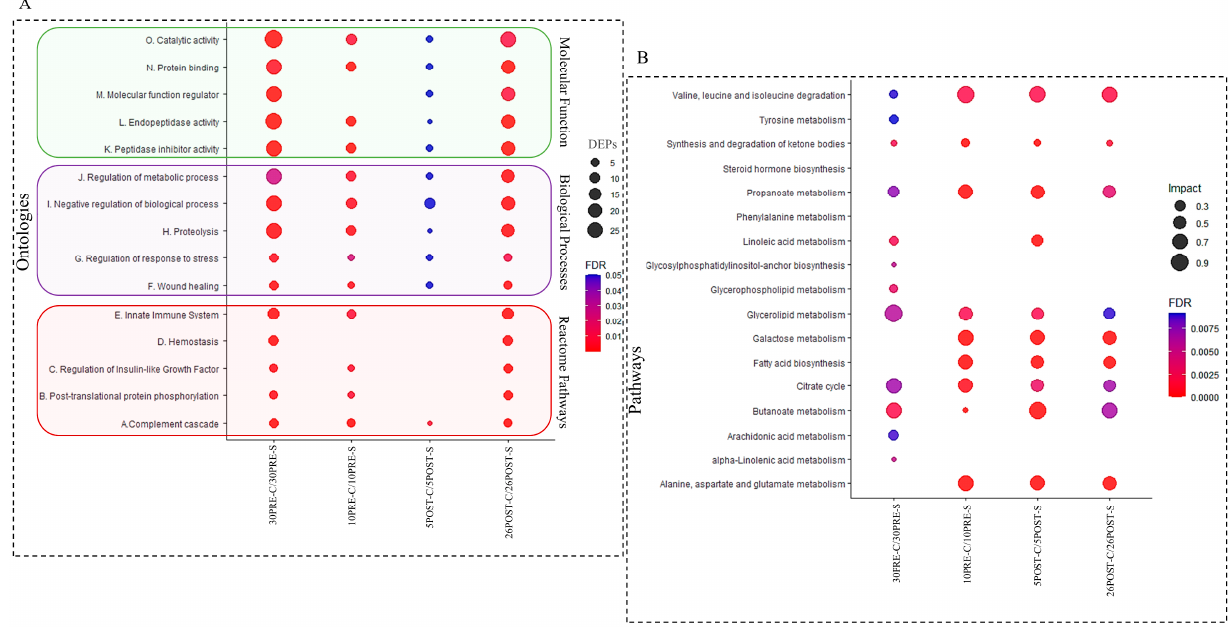
Figure 4. Gene ontologies and pathway enrichment for significant proteins and metabolite features. ( A ) The y-axis indicates the gene ontologies and Reactome pathway enrichment for proteins, and the x -axis indicates the group comparisons. The bubble size indicates the number of differentially expressed proteins (DEPs) involved in the ontologies. The color bar indicates the corrected p -value:e blue represents higher value and red represents lower value. ( B ) The y-axis indicates the KEGG pathway enrichment for metabolite features, and the x -axis indicates the group comparisons. The bubble size indicates the impact of the pathway represented by the number of differentially expressed metabolite features involved. The color bar indicates the corrected p -value: blue represents higher value and red represents lower